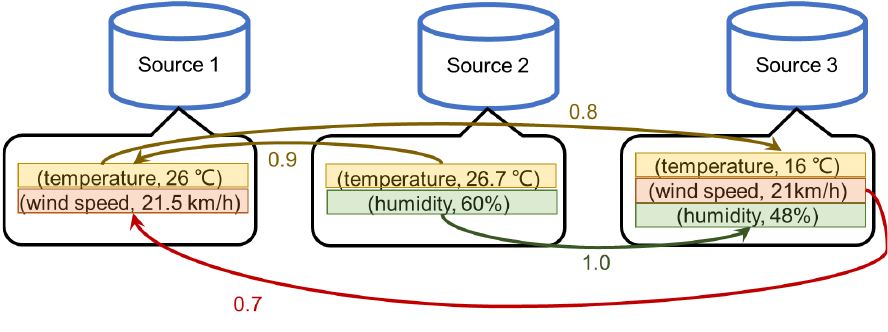
Figure 1. Data sources with different data